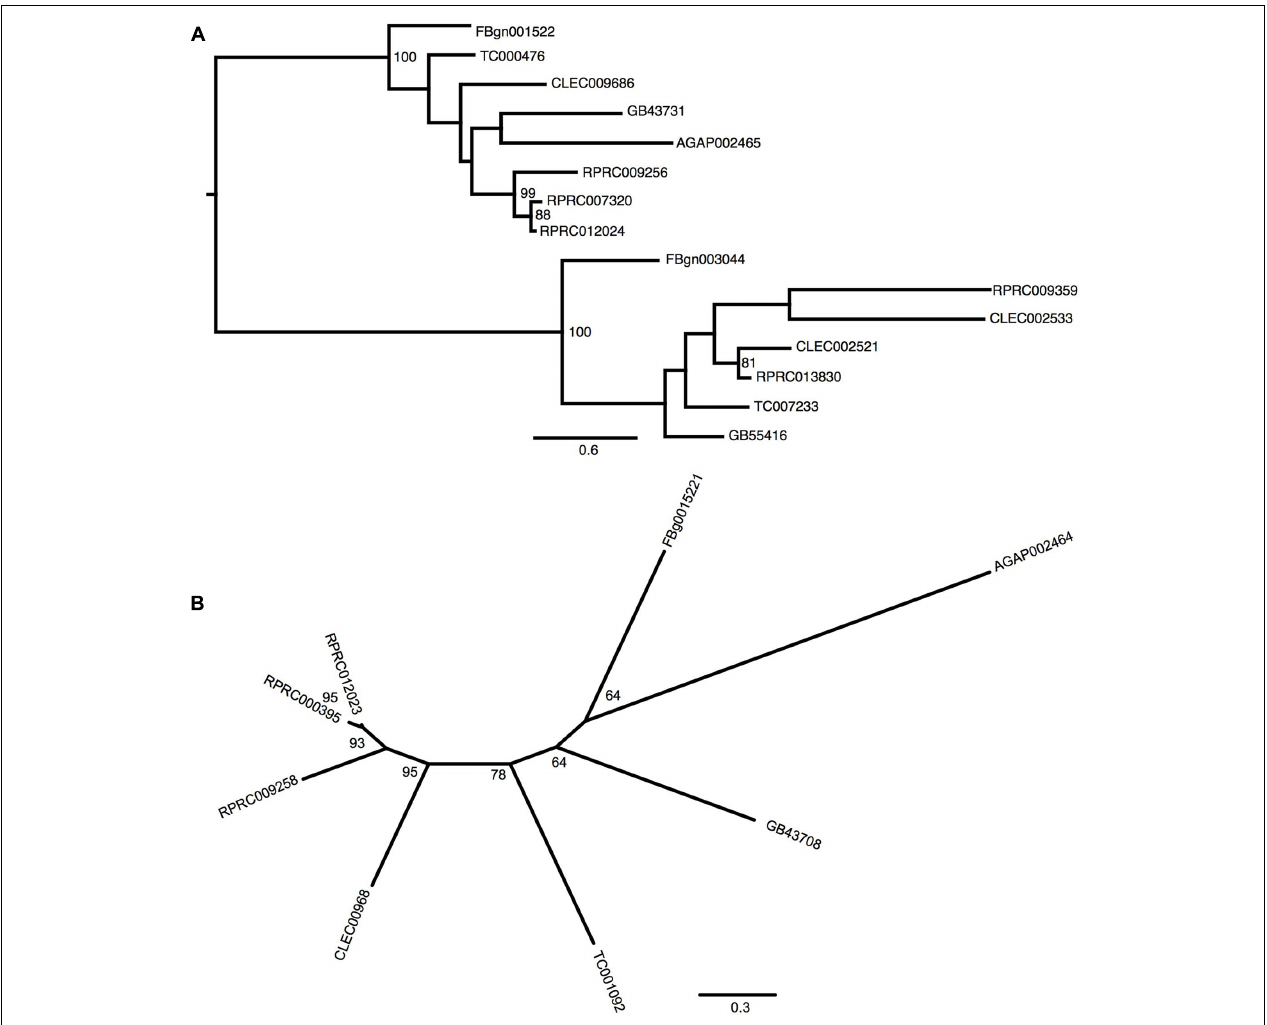
FIGURE 1 | Phylogenetic analysis of ferritins orthologs. Maximum-likelihood trees of ferritins HCH (A) and LCH (B) orthologs. Numbers on the branches are bootstrap support values from 500 replicates. Only numbers 50% or higher are shown. The sequence codes used were Rhodnius prolixus (RPRC), Drosophila melanogaster (FBg), Tribolium castaneum (TC), Cimex lectularius (CLEC), Apis mellifera (GB) and Anopheles gambiae